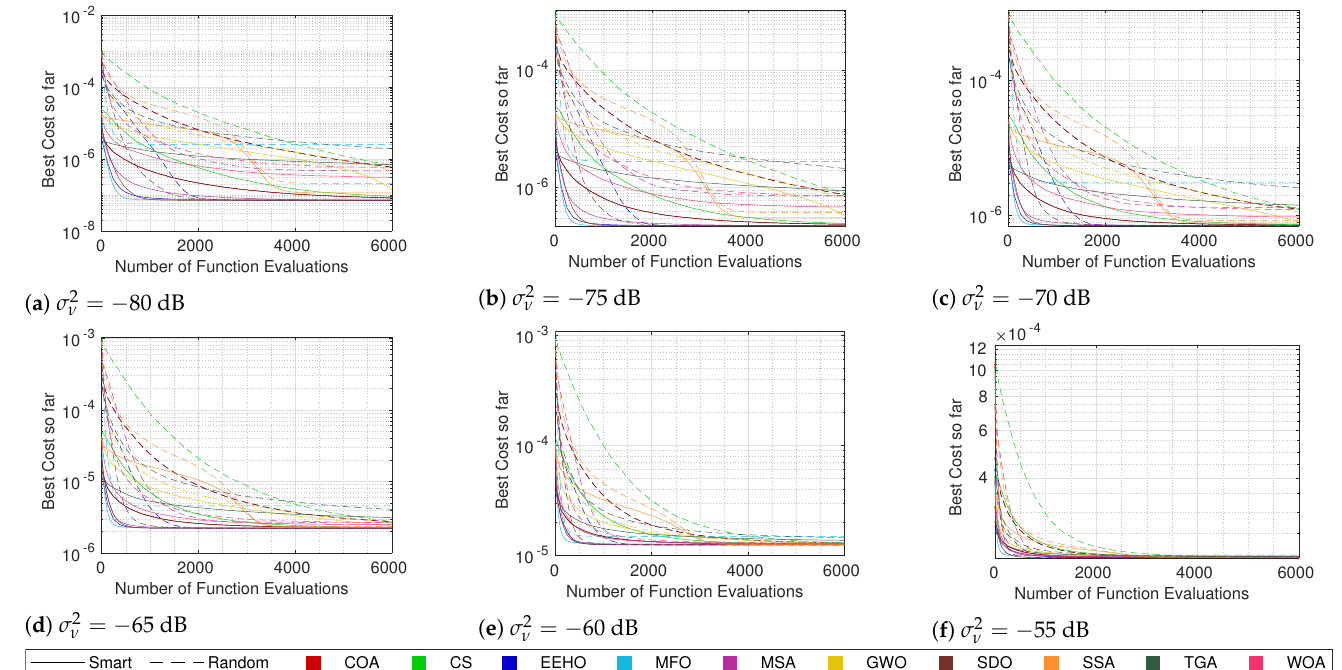
Figure 8. Cost convergence when using smart and random initialization for each algorithm when N =